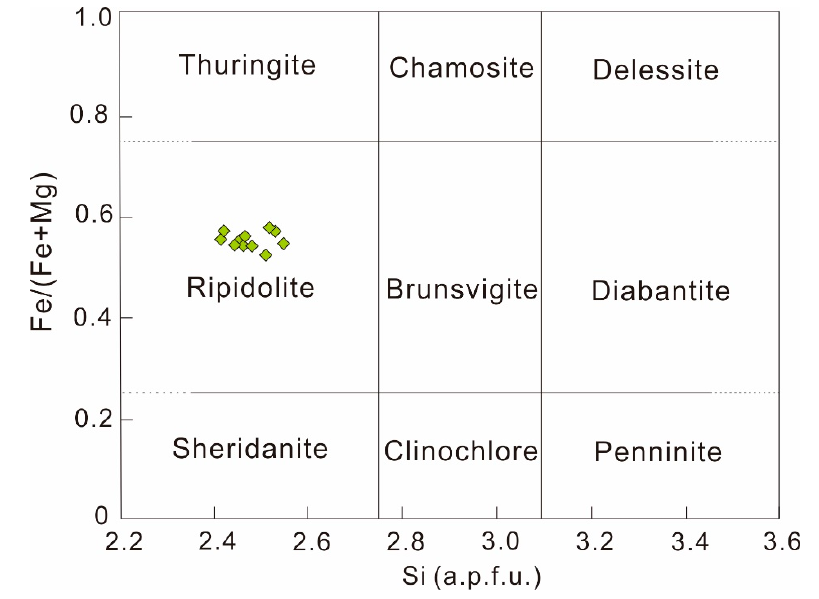
Figure 8. Chemical compositions of chlorite in the pressure shadows of arsenopyrite and pyrite at the Zhengchong gold deposit. Nomenclature and classification of chlorite [38].